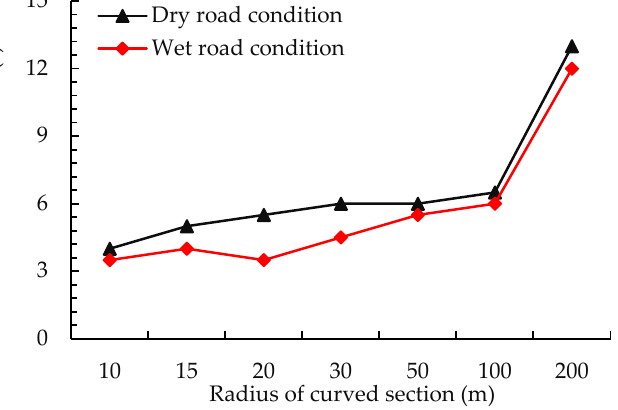
Figure 14. The duration of the “curve balance state” with various radii.